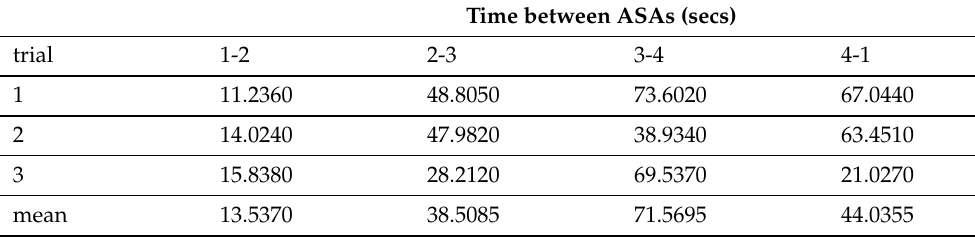
Table 2. The travel times between ASA waypoints for each trial with an obstacle between Waypoints 1 and